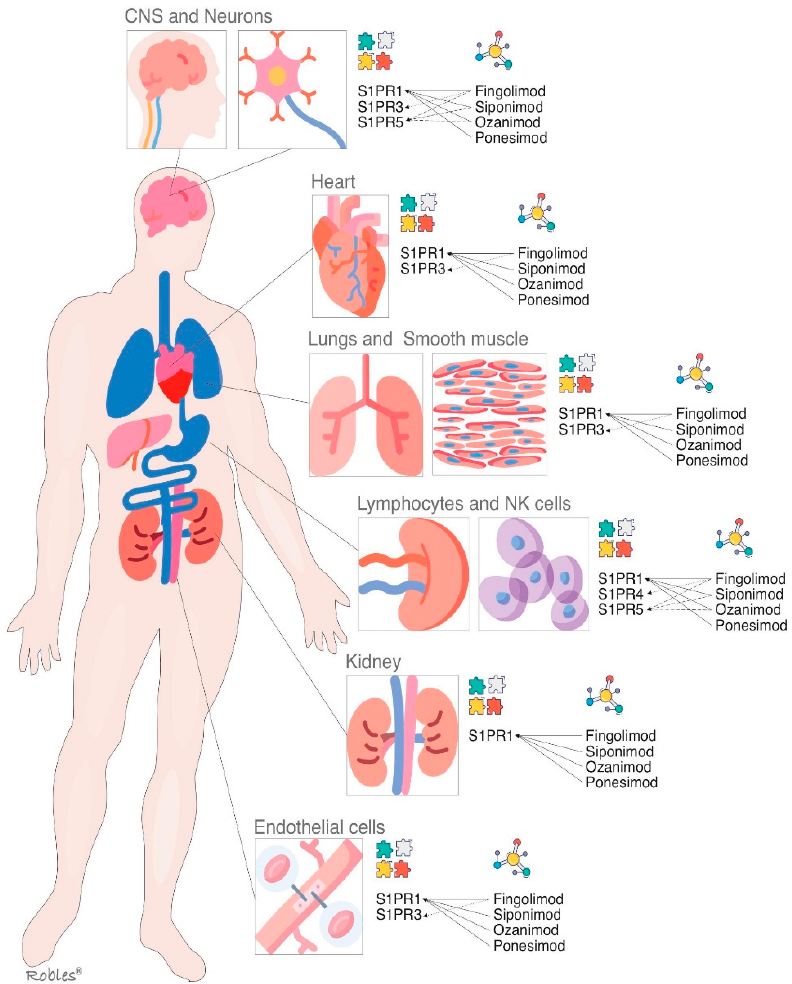
Figure 2. S1P receptors and their main localizations altogether with the S1P modulators and their targets. S1PR = Sphingosine1-phosphate receptor, CNS = central nervous system. targets. S1PR = Sphingosine1-phosphate receptor, CNS = central nervous